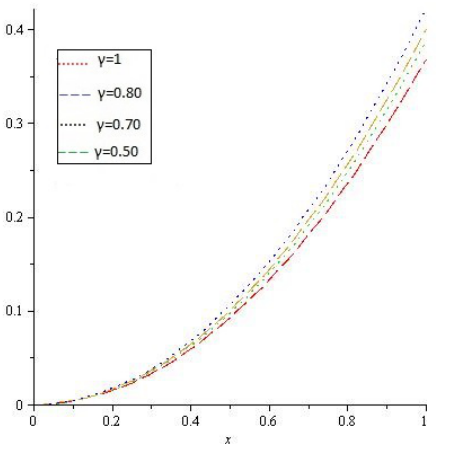
Figure 5. Numerical results of υ ( x , t ) for Example 3, for different value of γ